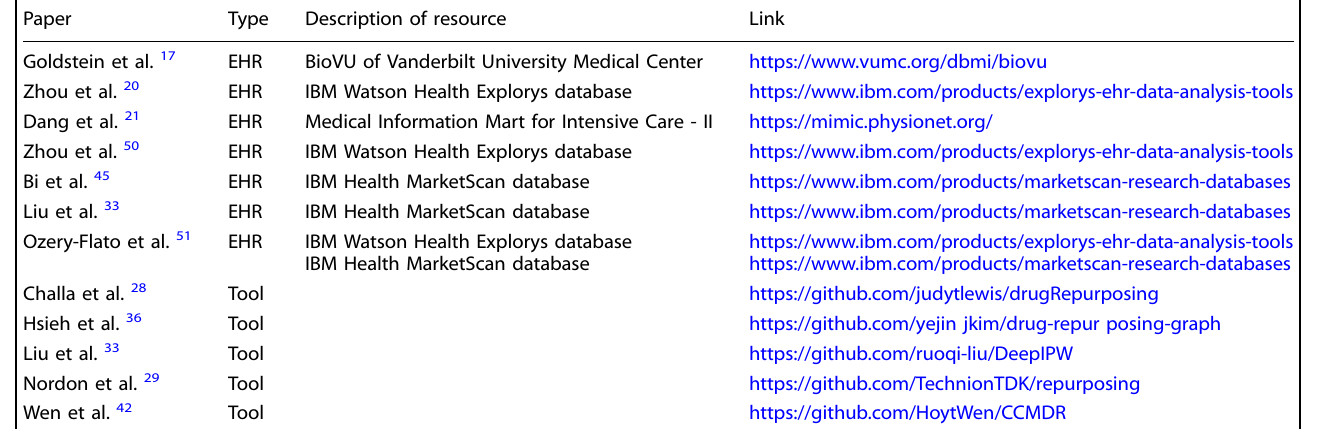
Table 1. Summary of publically shared data and